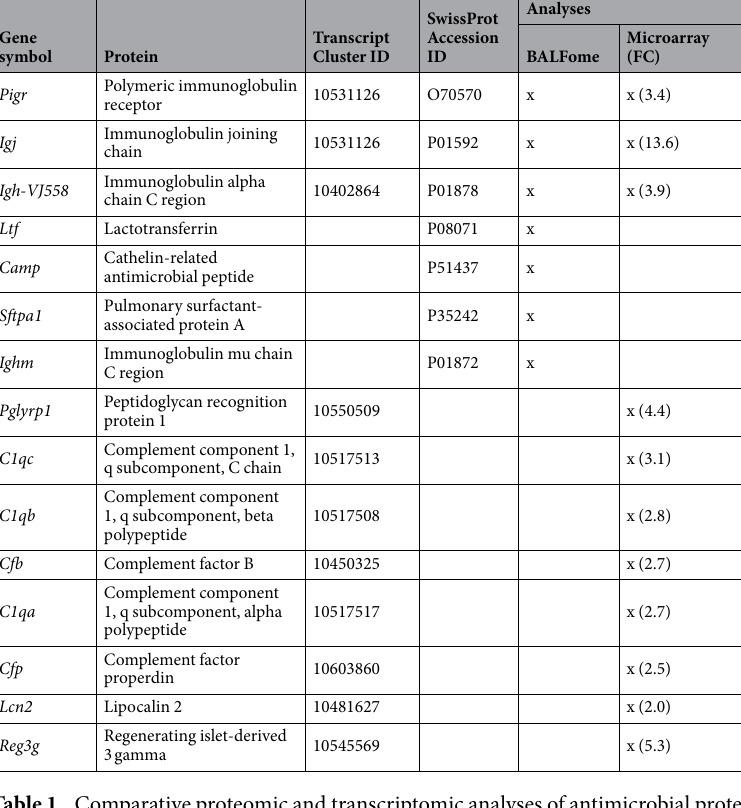
Table 1. Comparative proteomic and transcriptomic analyses of antimicrobial proteins in SPC-HAxTCR-HA vs. SPC-HA lungs. Definition of abbreviations: FC = fold change, x = protein uniquely detected in SPC-